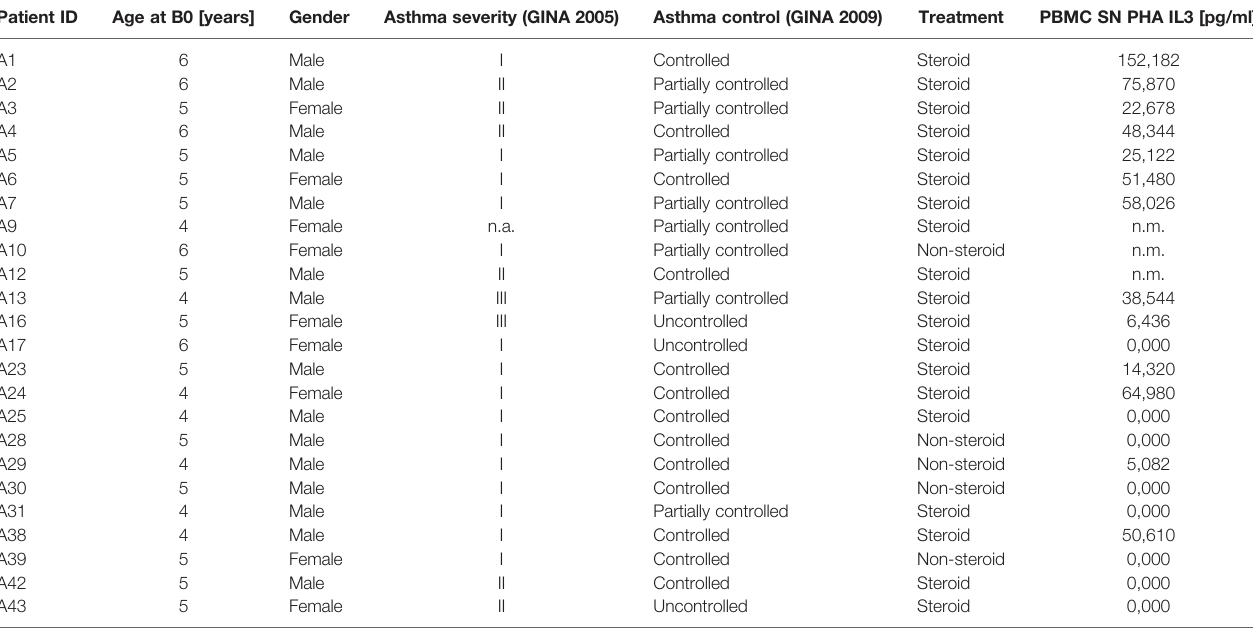
TABLE 1 | Clinical data of the asthma PreDicta cohort WP1-UK-ER analyzed at the baseline visit. Patient